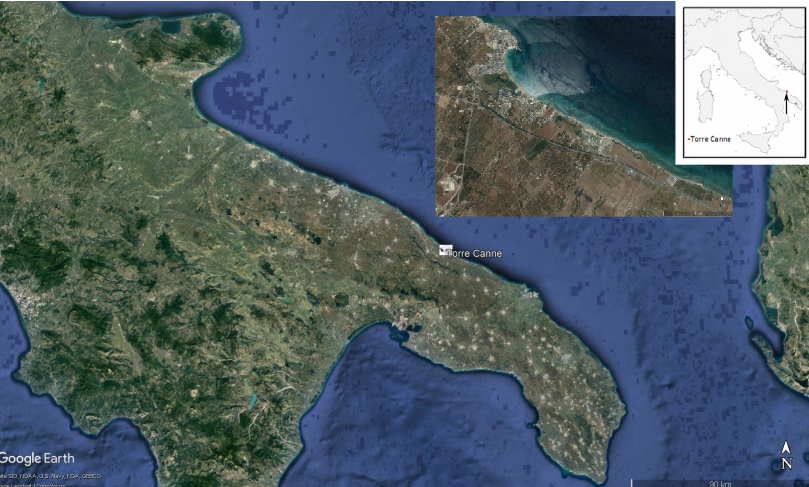
Figure 1. Torre Canne location along Apulia region coasts in the southern of